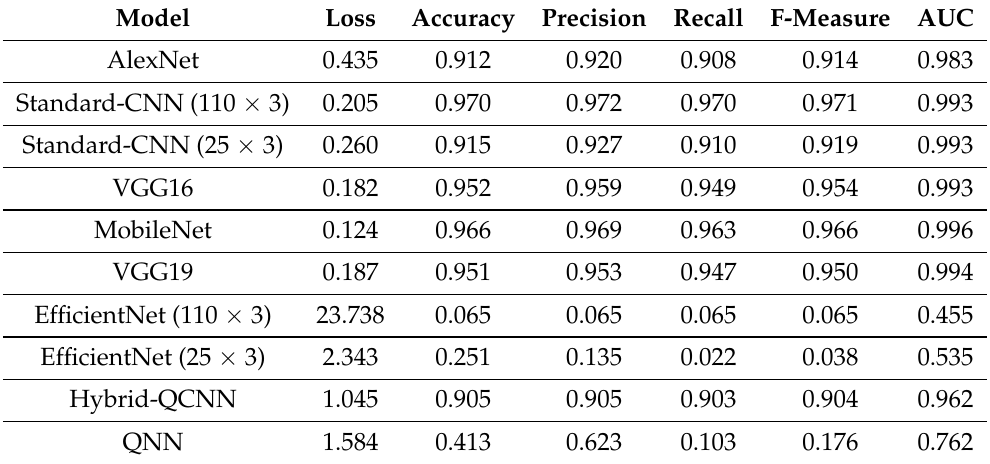
Table 2. Experimental results obtained with all the models involved in the evaluation by exploiting the test